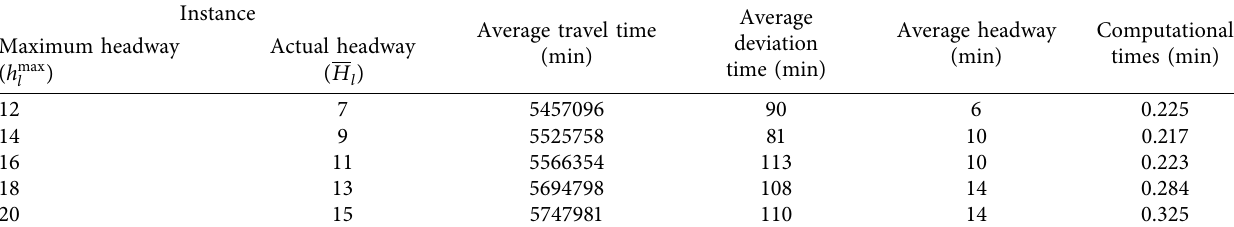
Table 12: Analysis of different maximum headways and actual headways.